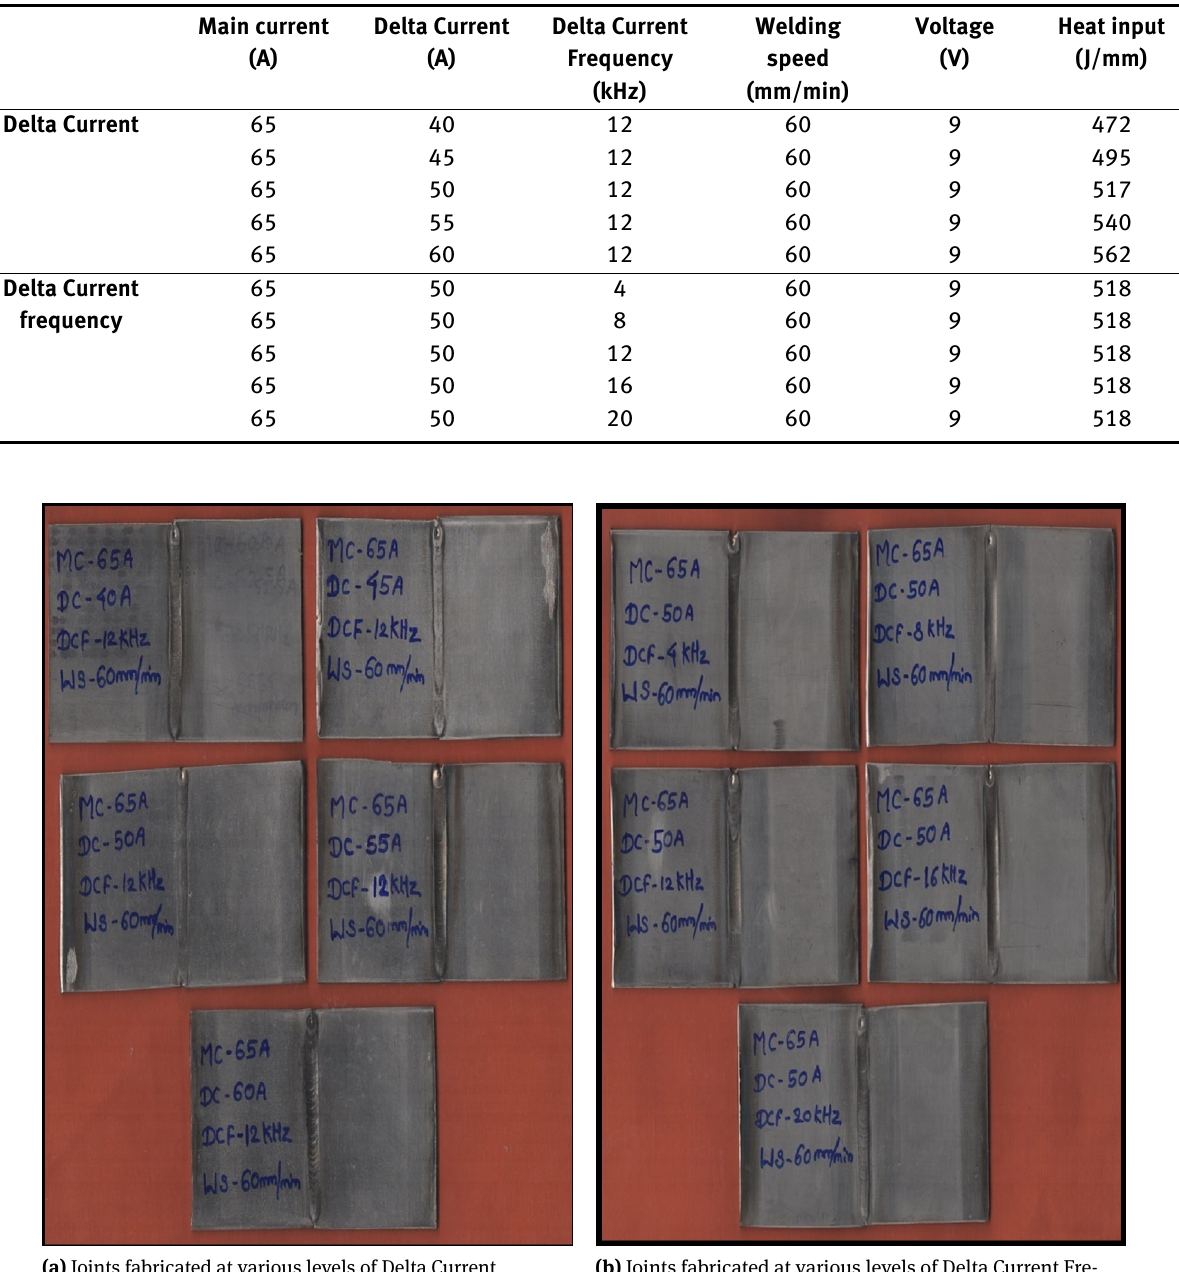
Table 3: Process parameters for GTCA welding of Inconel 718 alloy